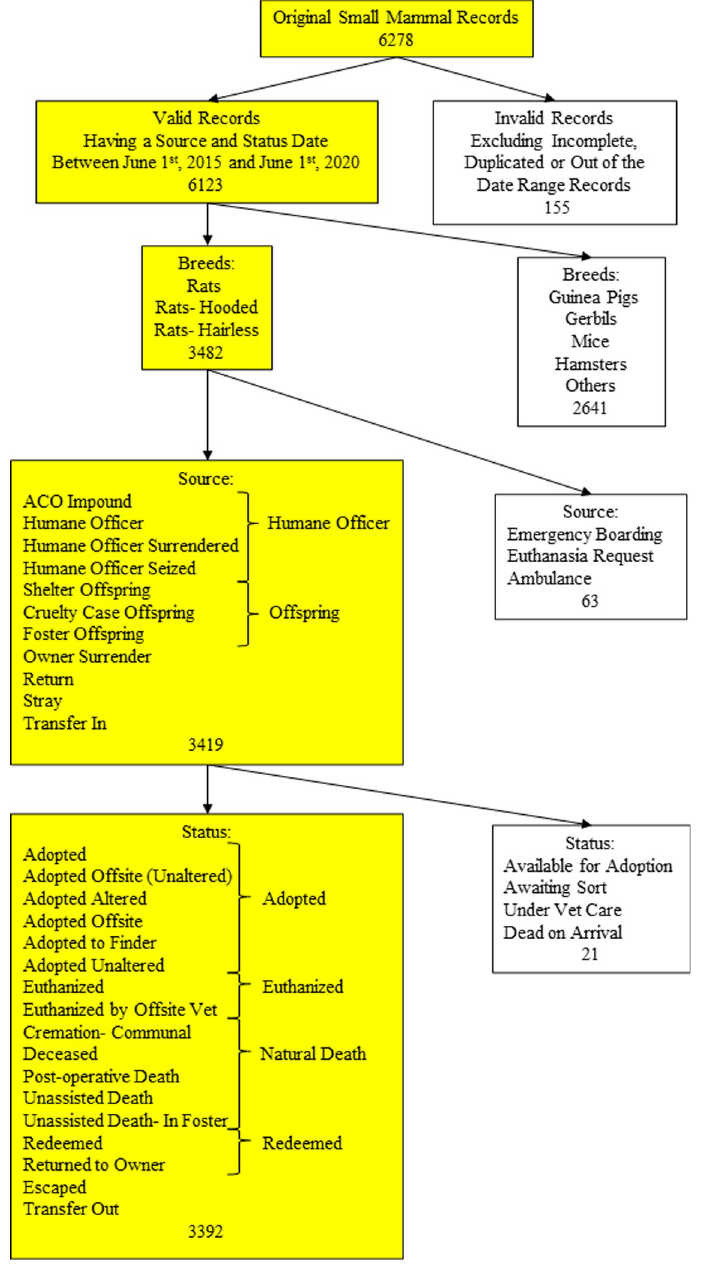
Fig 1. A Flow chart for data collation. Yellow squares indicate the direction of data